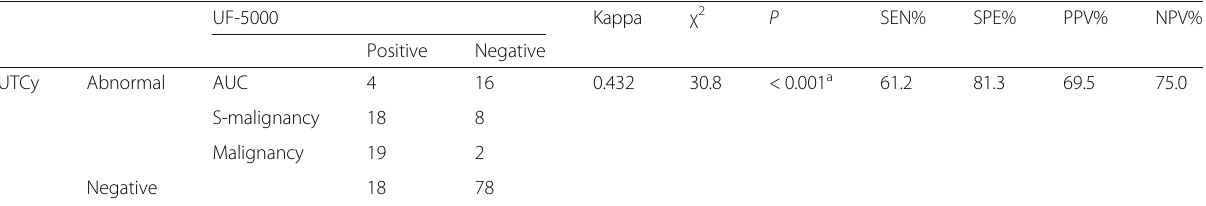
Table 2 Cross-tabulation of UTCy and Atyp. C test results